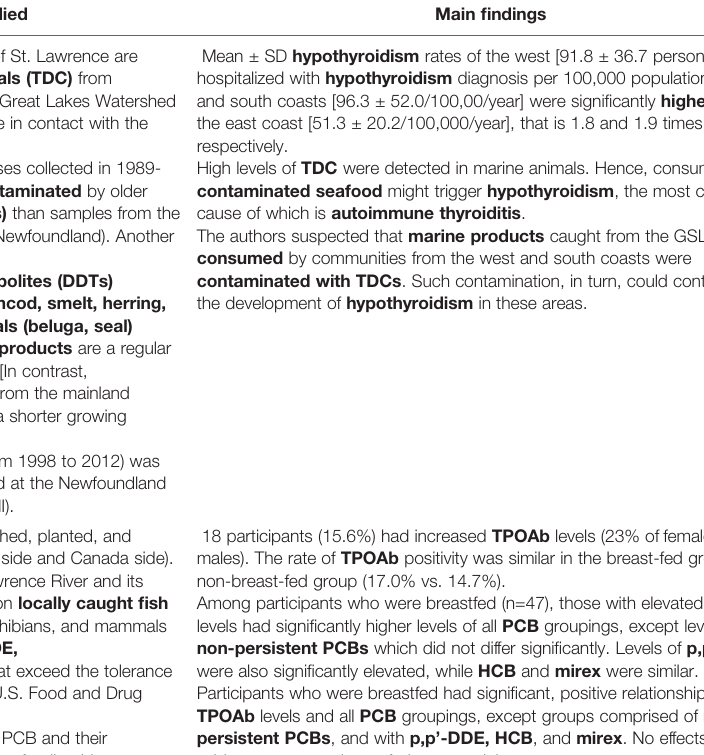
TABLE 3 | Studies on the relationship between consumption of contaminated fi sh and thyroid disorders in humans. * Reference Methods and subjects studied Main fi